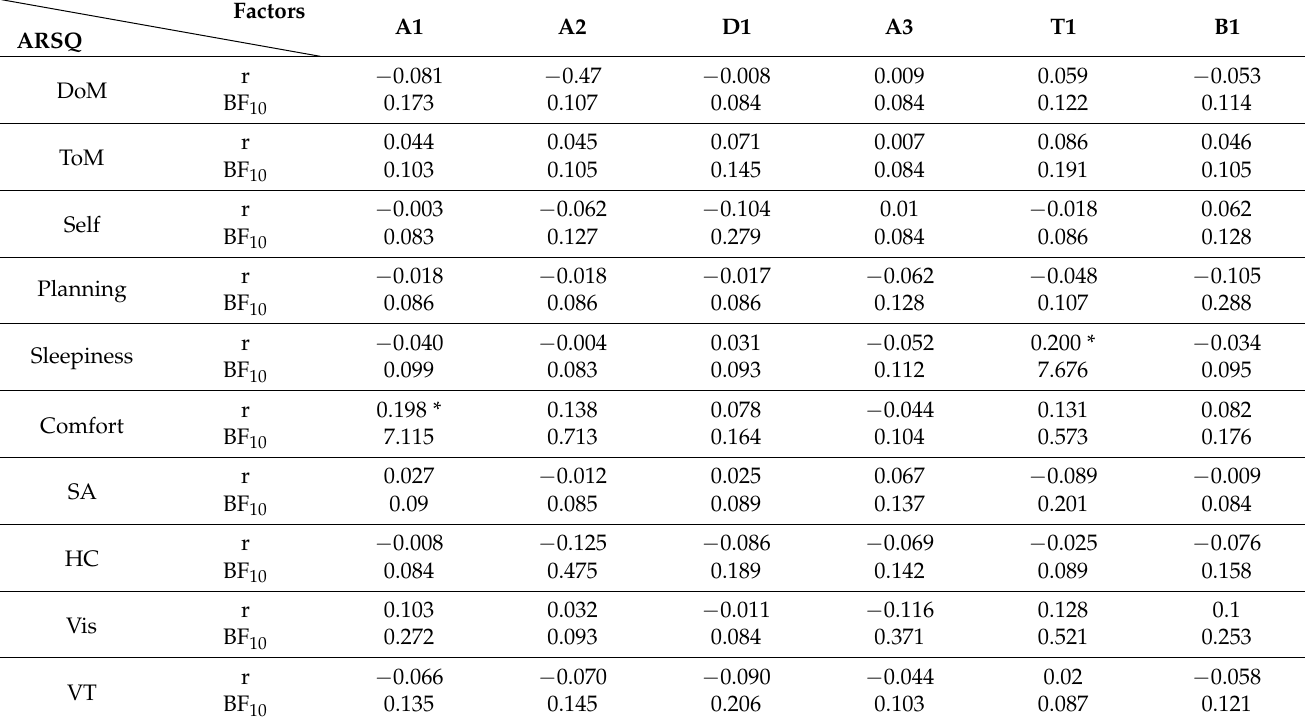
Table 1. Bayesian Pearson’s correlation coefficient between six data-driven EEG components and ARSQ